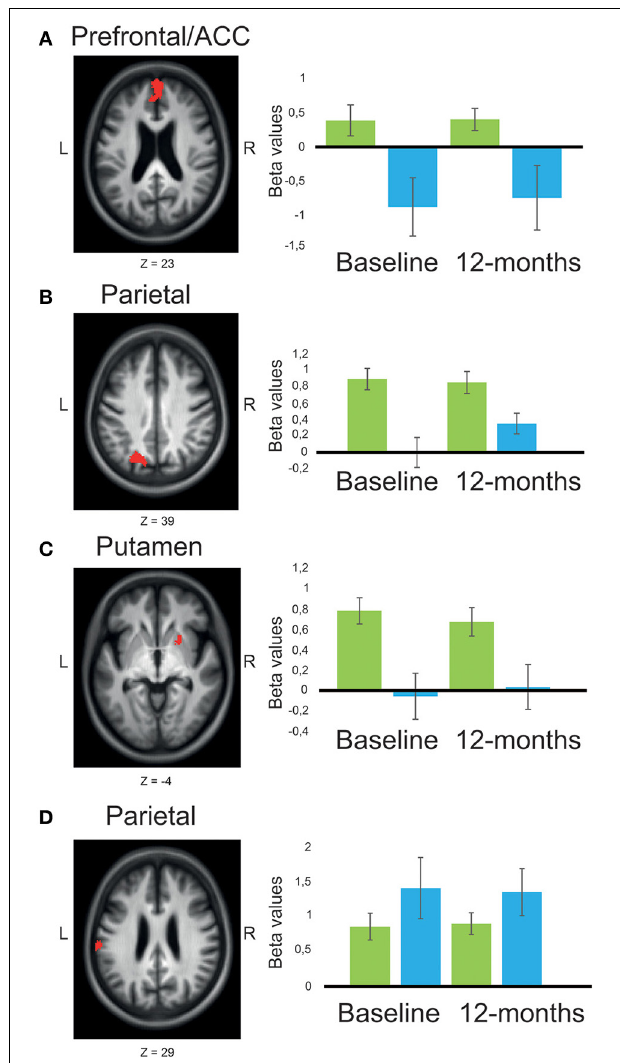
FIGURE 3 | Main effects of group across time-points, comparing BOLD-signal intensity in patients with Parkinson’s disease with or without MCI. (A) The presented results are chosen to illustrate fronto-striatal respective posterior cortical circuitry (with two opposite patterns). significant main effect of group (red) was shown in bilateral medial PFC/ACC (A) , left superior parietal/occipital cortex (B) , and putamen (C) , where patients with MCI ( n = 11) showed reduced BOLD-signal intensity compared to patients without MCI ( n = 28). An opposite pattern was shown in left supramarginal gyrus (D) were patients with MCI showed larger BOLD-signal intensity compared to patients without MCI. Mean beta values are presented as plots contrasting working-memory 2-back task with the baseline resting condition for patients with Parkinson’s disease without MCI (green), and patients with MCI (blue). Error bars are 1 SE. Z, anatomical location in Montreal Neurological Institute transversal space. The statistical threshold in the pictures (red clusters) is set to p < 0 . 005 to increase visibility.